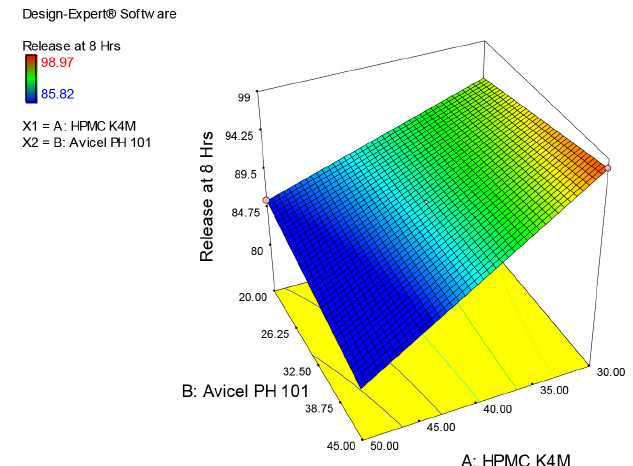
FIGURE 5c - Response surface model (RSM) showing effect of independent variables HPMC K4M and Avicel pH 101 on Drug release in 8 hours.